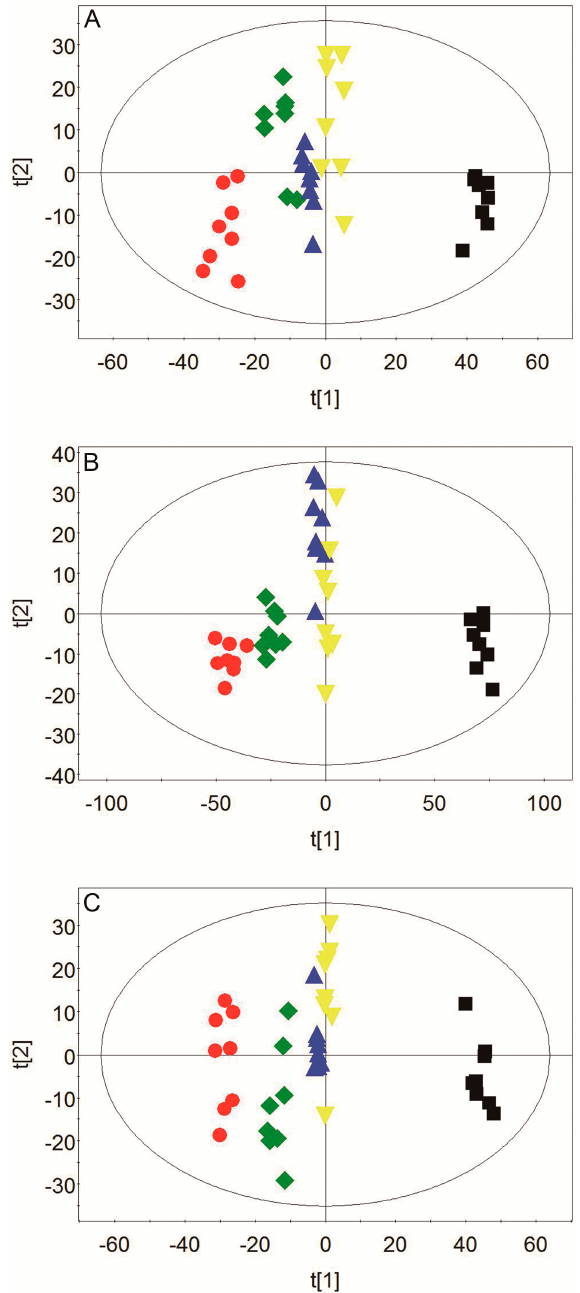
Figure 6. Scores plots of partial least squares discriminant analysis (PLS-DA) for plasma ( A ), urine ( B ), and brain tissue ( C ). Control group; Model group; Nimodipine group; H-TCNDS group; L-TCNDS group. H-TCNDS meaned high dosage of TCNDS (316.34 mg·kg −1 ·d −1 ), and L-TCNDS meaned low dosage of TCNDS (158.17 mg·kg −1 ·d −1